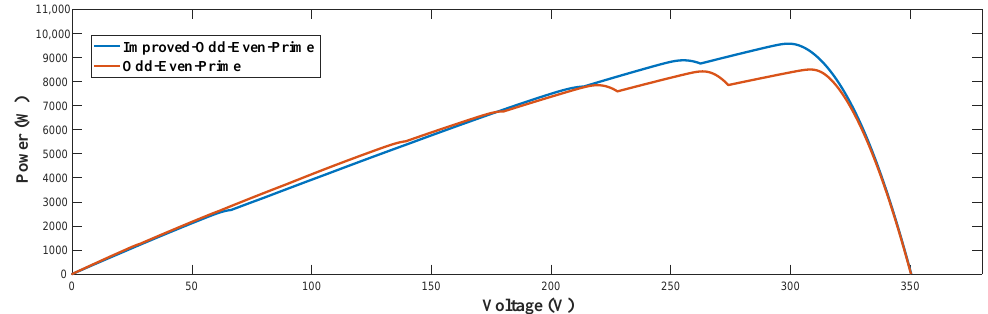
Figure 21. Voltage–power characteristics of 8 × 9 PV array at Bottom-Left PSC.